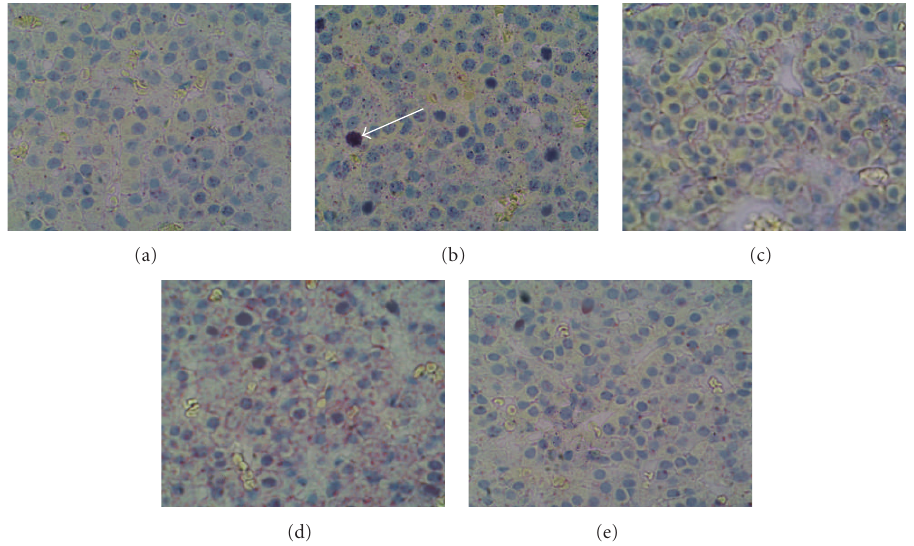
Figure 2: Immunohistochemical staining for the proliferation cell nuclear antigen (PCNA) in anterior pituitary of rats; (a) control diethylstilboestrol- (DES-) untreated group, (b) control DES-treated group, (c) DES and AT1 blocker (losartan) cotreated group, (d) DES and AT2 blocker (PD12319) cotreated group, and (e) DES and angiotensin converting enzyme inhibitor (captopril) cotreated group. White arrow indicates PCNA-positive cell.